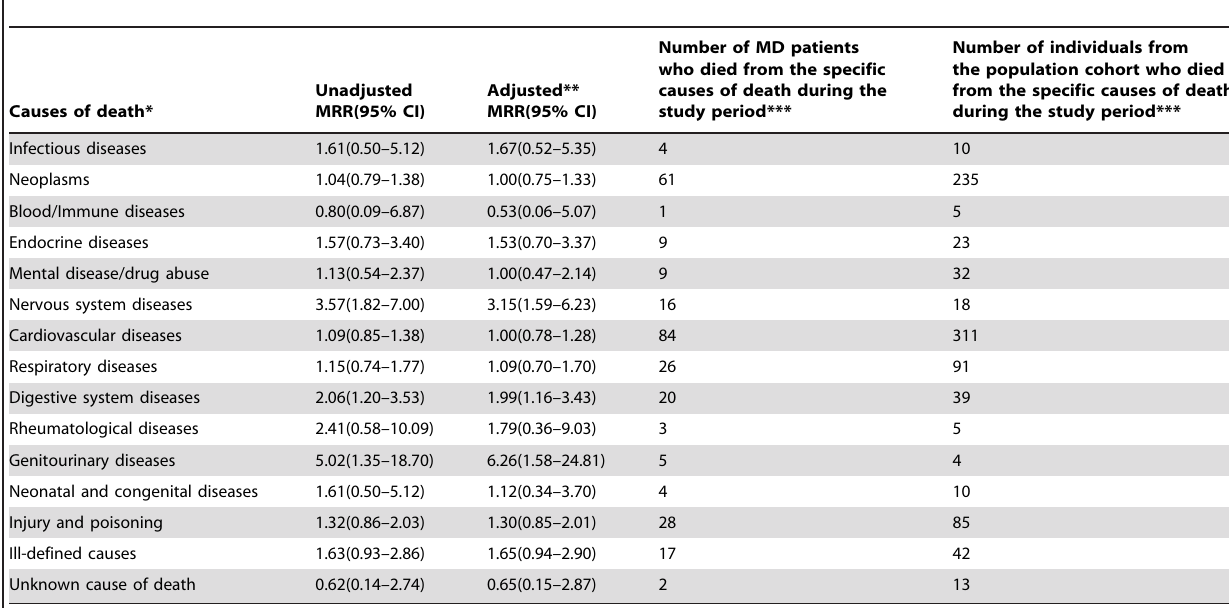
Table 3. Mortality rate ratios (MRR) for cause specific death in MD patients compared to individuals from the population cohort.